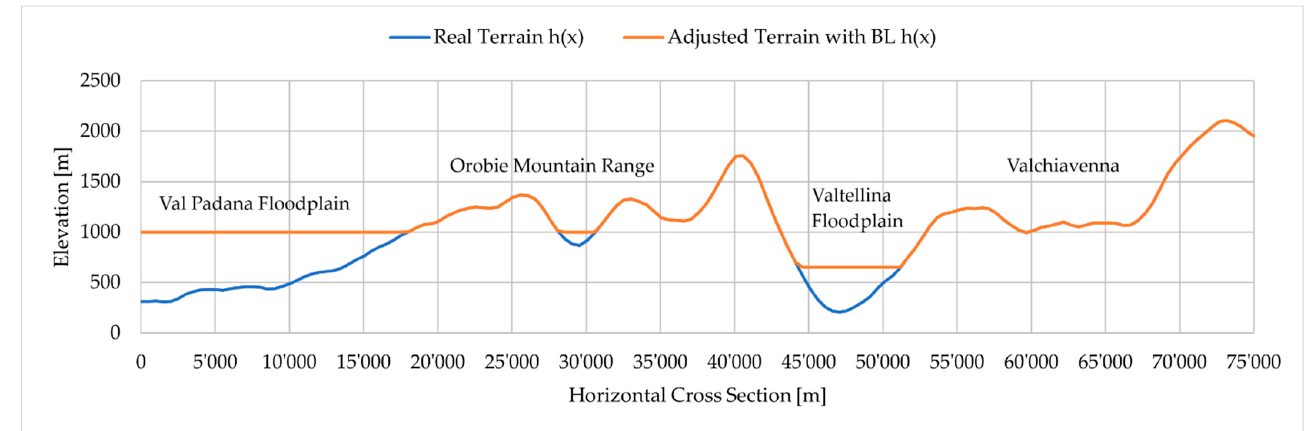
Figure 6. Adjustment of the terrain elevation profile considering the existence of boundary layer (BL).